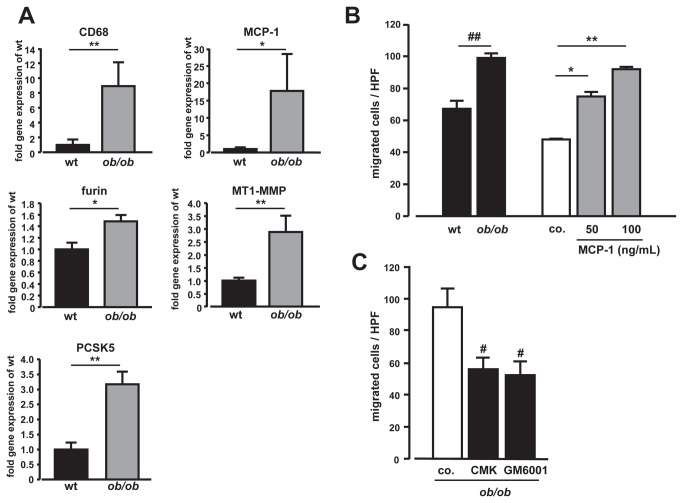
Obese white adipose tissue (WAT) gene expression and impact on macrophage migration.(A) WAT derived from wild-type (wt) and obese ob/ob mice was subjected to qRT-PCR. Increased gene expression of CD68, MCP-1, furin, MT1-MMP, and PCSK5 was found in ob/ob mice (*p<0.05; **p<0.01 vs. wt). (B) Supernatants from WAT cultures of ob/ob mice increased THP-1/ϕ migration (##p<0.05 vs. wt), comparable to MCP-1 (*p<0.05 vs. control, co.; **p<0.01 vs. 50 ng/mL MCP-1). (C) Supernatant-facilitated migration was inhibited by dec-CMK (CMK, 50 µmol/L; 12h) or the MMP-inhibitor GM6001 (50 µmol/L; 12h) (both #p<0.05 vs. controls, co.). n=3.